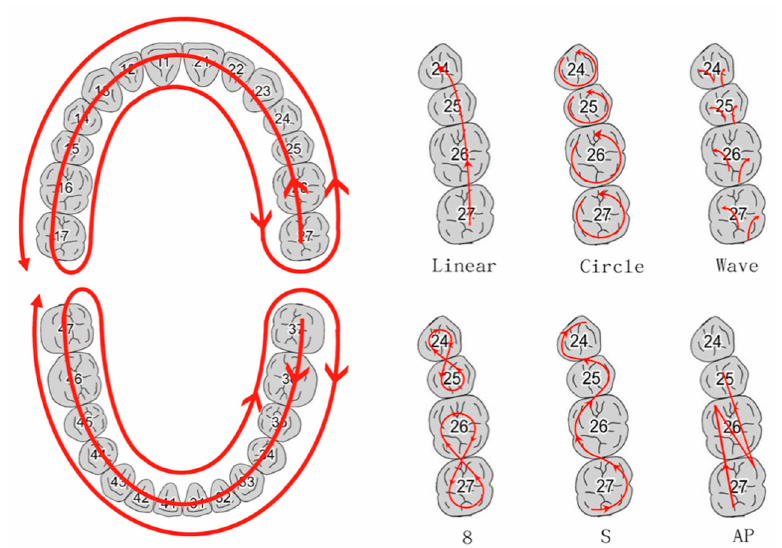
Figure 1. One scan path with six scan head movements. Linear movement refers to moving along the outline of the dental arch. Circle movement refers to making a counterclockwise circle movement for each tooth along the dental